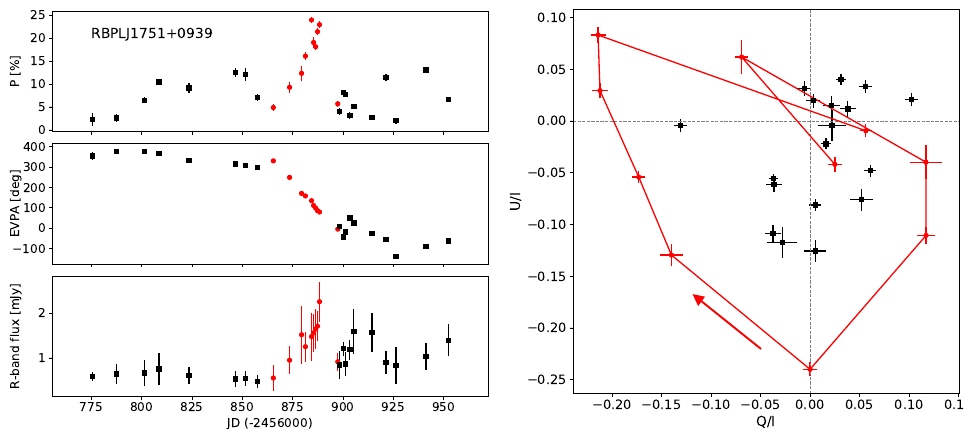
Figure 2. An example of an EVPA rotation (marked by the red circles). Based on data from